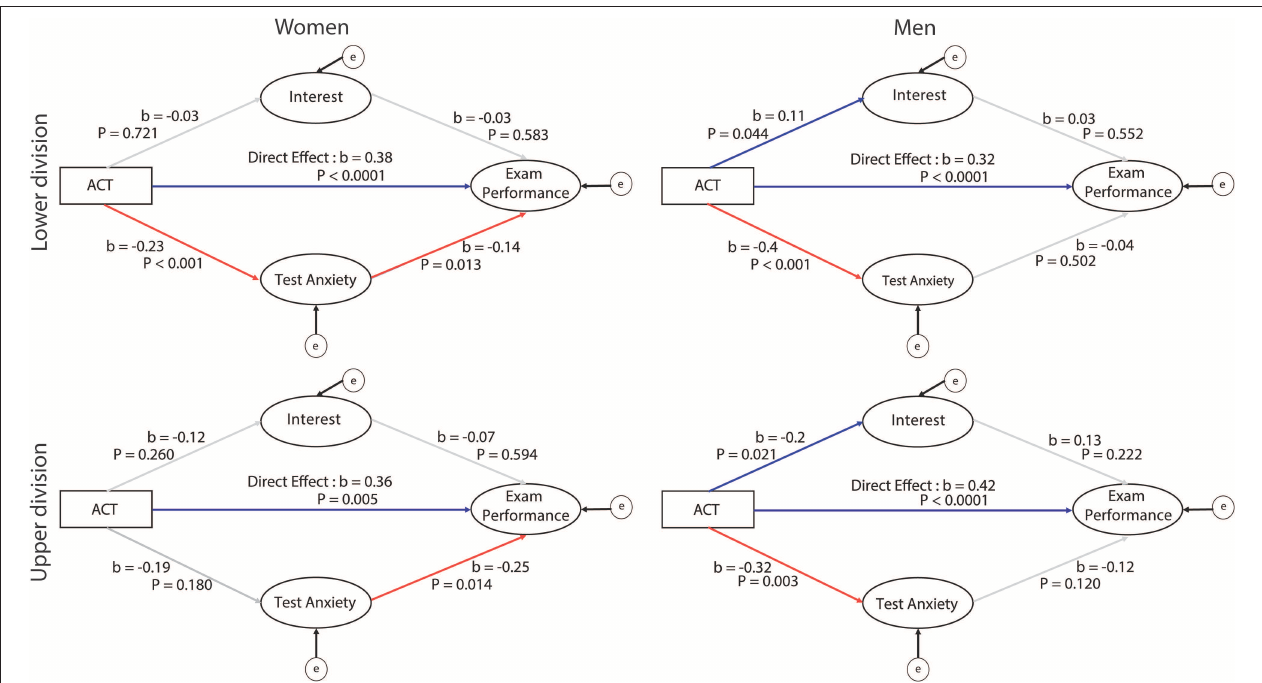
FIGURE 4 | Partial mediation analyses show differences in the significant effects of incoming preparation (ACT) on exam performance for female and male students in the College of Science and Engineering (CSE) in lower division and upper division courses. Red arrows depict negative effects and blue arrows show positive effects. ACT has direct, positive effects on exam performance for all lower division and upper division students. For female students at the lower division, ACT predicts test anxiety, which negatively predicts exam performance. For women in upper division courses, ACT does not predict test anxiety, but test anxiety negatively predicts exam performance. For male students at the lower and upper division, ACT negatively affects test anxiety, but test anxiety does not in turn influence exam performance. In the graphs, “e” circles indicate error terms in estimations of the structural equation model variables.